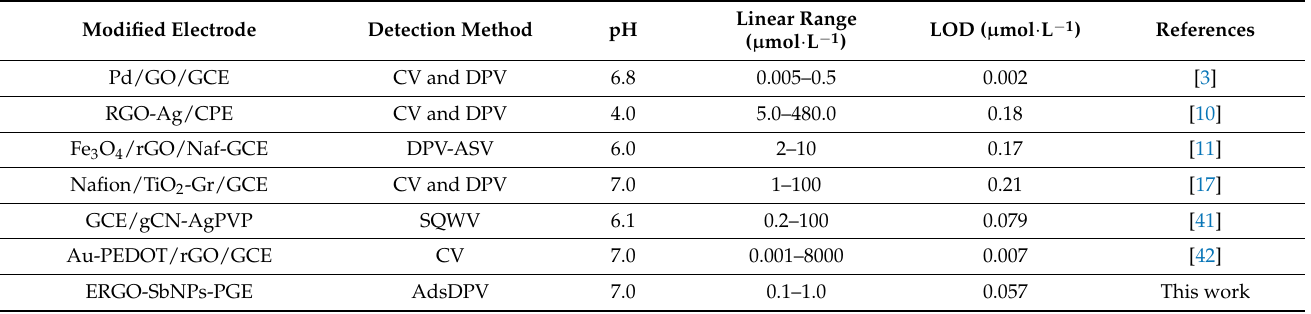
Figure 8. DPVs obtained at ERGO-SbNPs-PGE in 0.1 mol·L −1 phosphate buffer solution (pH 7.01) containing concentrations of PC (A – J: 0.1, 0.2, 0.3, 0.4, 0.5, 0.6, 0.7, 0.8, 0.9, and 1.0 µmol·L −1 ) in ( A ) and the corresponding calibration plots in ( B ). Table 3. Comparison of detection limits on ERGO-SbNPs-PGE with other modified electrodes at different pH and detection methods . Modified Electrode